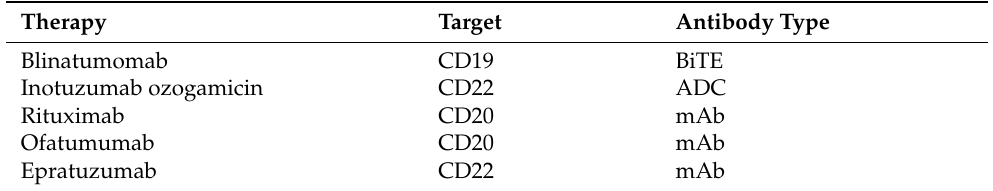
Table 2. Antibodies used in ALL